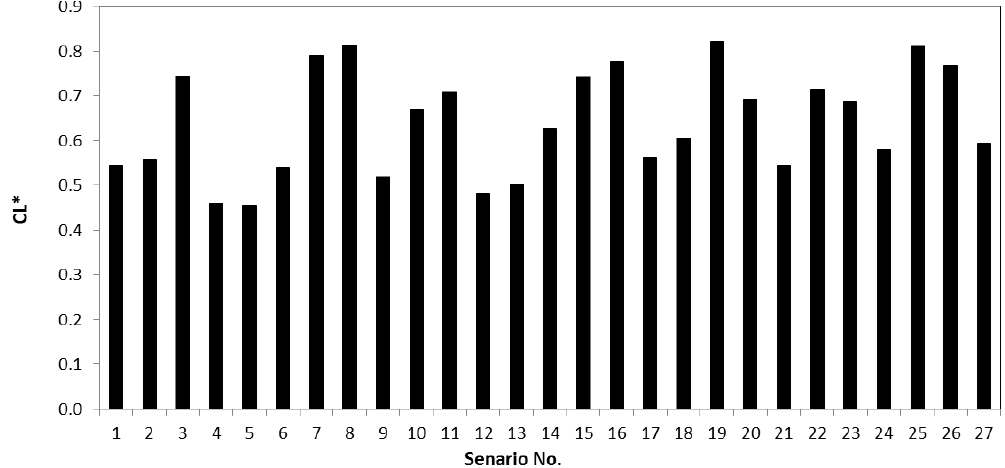
Figure 7 . Variation of C a∗ at the TOPSIS method